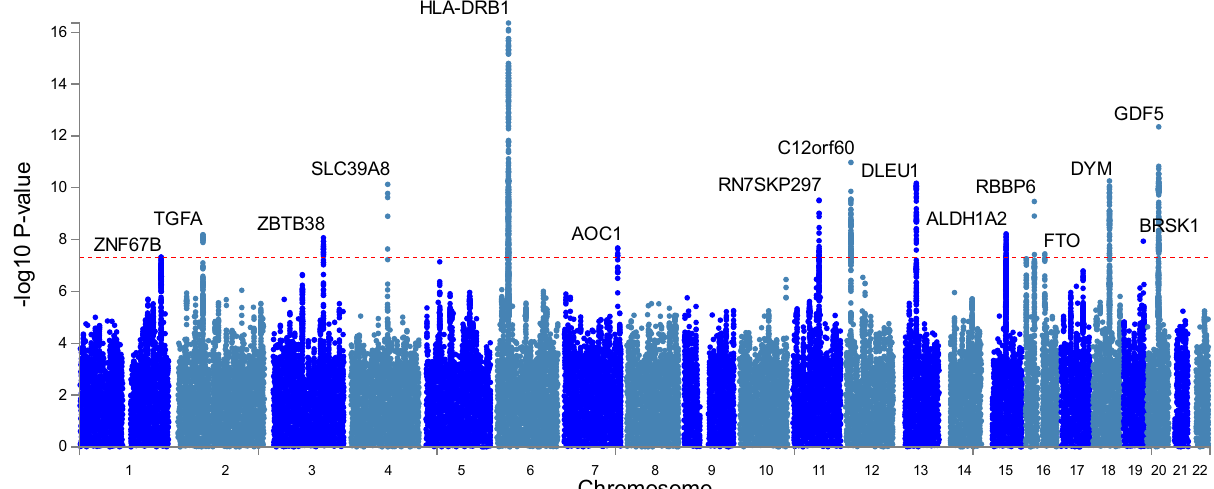
Fig. 1 Manhattan plot of low grip strength genome-wide association study -log10 p values. The p values are from a fi xed-effects meta-analysis of 256,523 Europeans aged 60 or older from 22 cohorts. The outcome was low hand grip strength grip strength cutoff (males <30 Kg, females <20 Kg). The x-axis is the chromosomal location, and the y-axis is the – log 10 p value for each genetic variant. The horizontal red line is the threshold for genome-wide Table 1. The nearest gene is displayed for each locus.